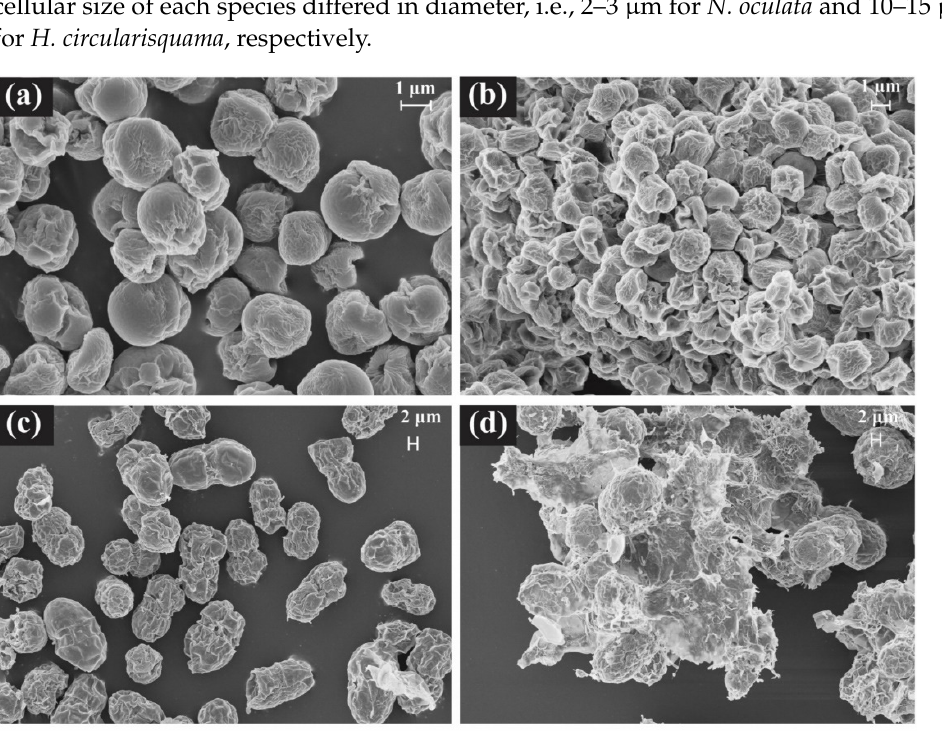
Figure 3. Scanning electron micrograph of N. oculata ( a , b ) and H. circularisquama ( c , d ) under normal and vanadium solution mixed conditions, respectively.